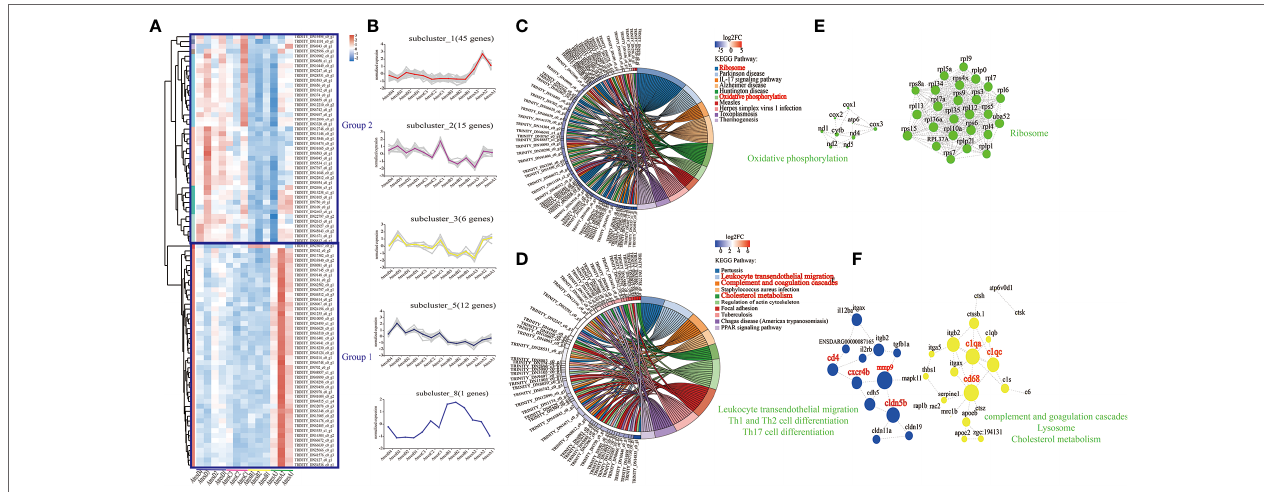
FIGURE 7 | Functions, dynamic changes, and protein–protein interaction networks of DEGs among AtresA vs. AtresB, AtresB vs. AtresC, and AtresB vs. AtresD. (A) Hierarchical clustering showing two groups of the expression levels of DEGs at five stages. (B) Expression trends of genes in five clusters during five stages. (C) Kyoto Encyclopedia of Genes and Genomes (KEGG) pathway analysis of DEGs in group 1. (D) Kyoto Encyclopedia of Genes and Genomes (KEGG) pathway analysis of DEGs in group 2. (E) Protein–protein interaction networks of DEGs in group 1 enriched in “oxidative phosphorylation” and “ribosome” pathways. (F) Protein–protein interaction networks of DEGs in group 2 enriched in “leukocyte transendothelial migration”, “Th1 and Th2 cell differentiation”, “Th17 cell differentiation”, “complement and goagulation cascades”, “lysosome”, and “cholesterol metabolism”